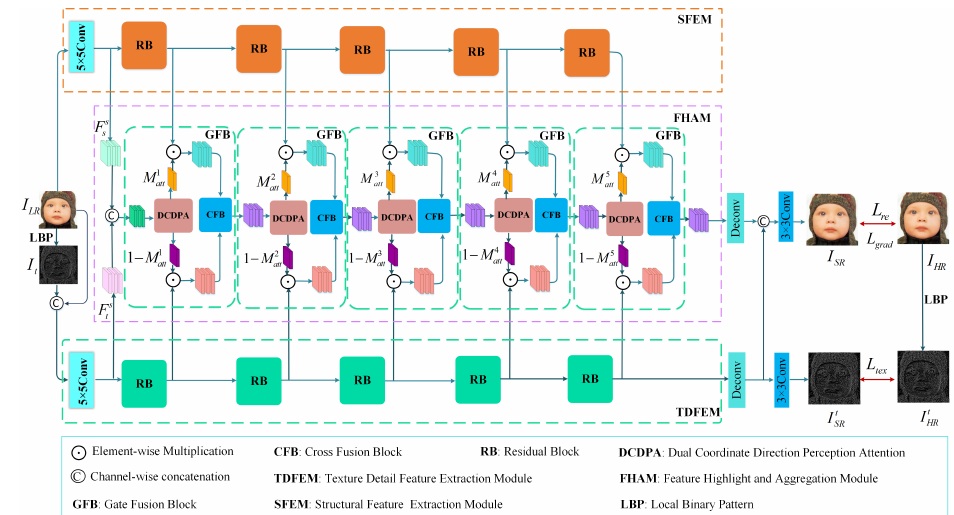
Figure 1. The framework of the proposed